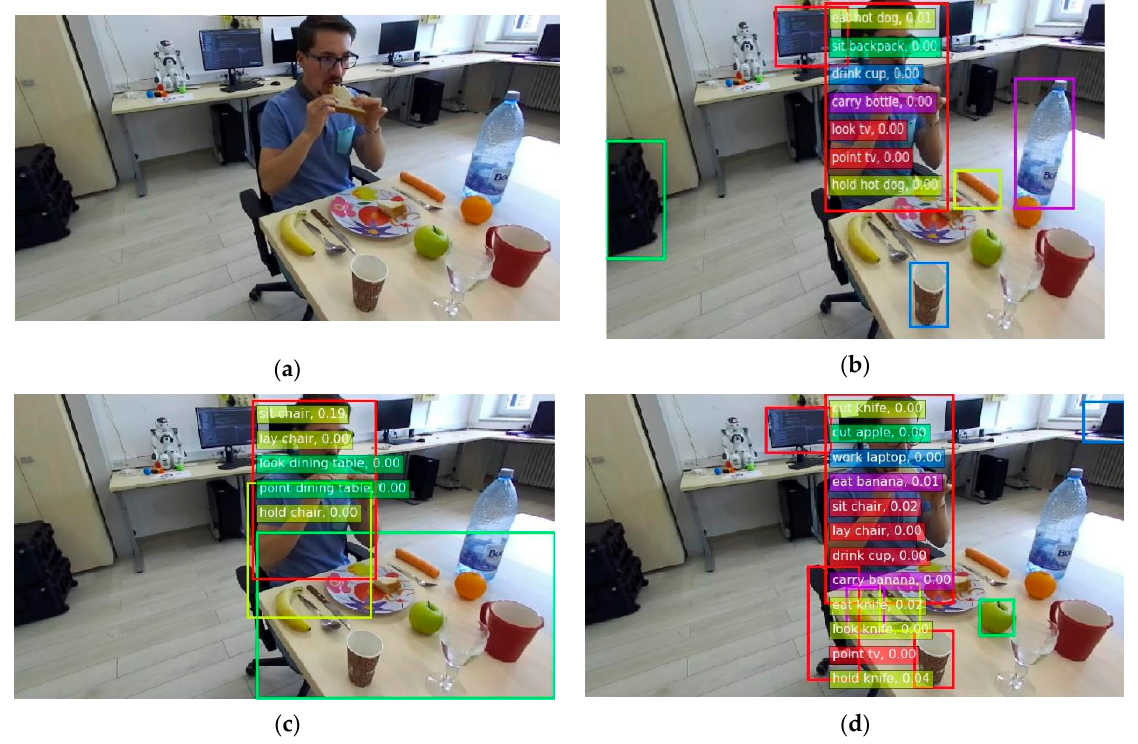
Table 4. HOI detection evaluation for agent and role.